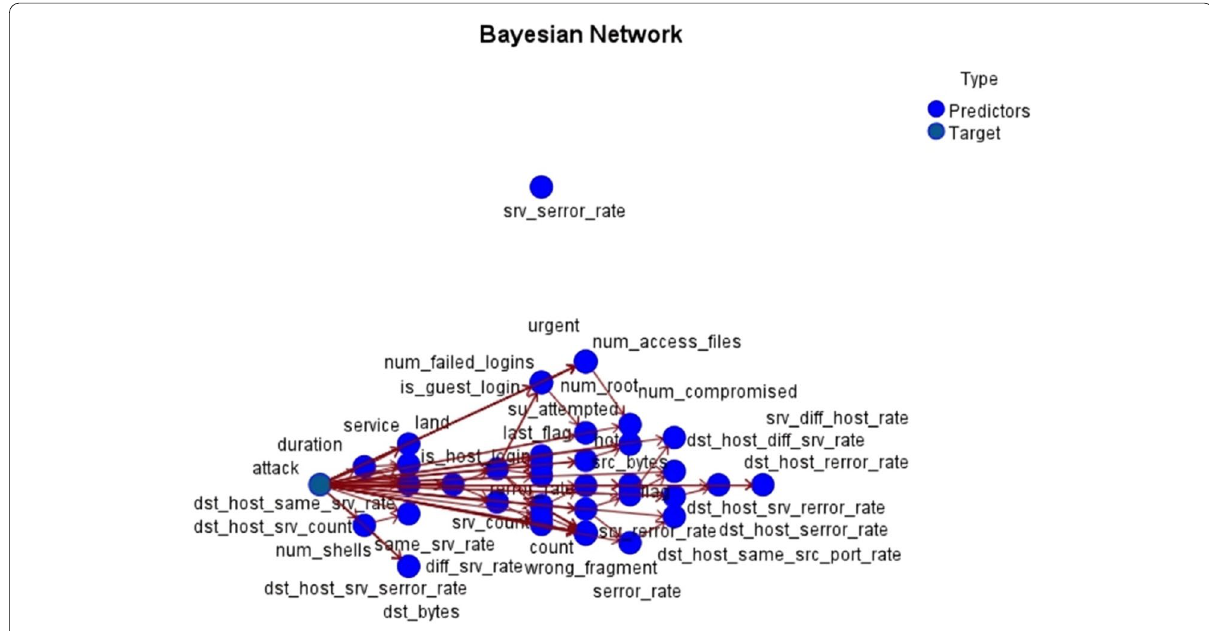
Fig. 8 Bayesian Network Details